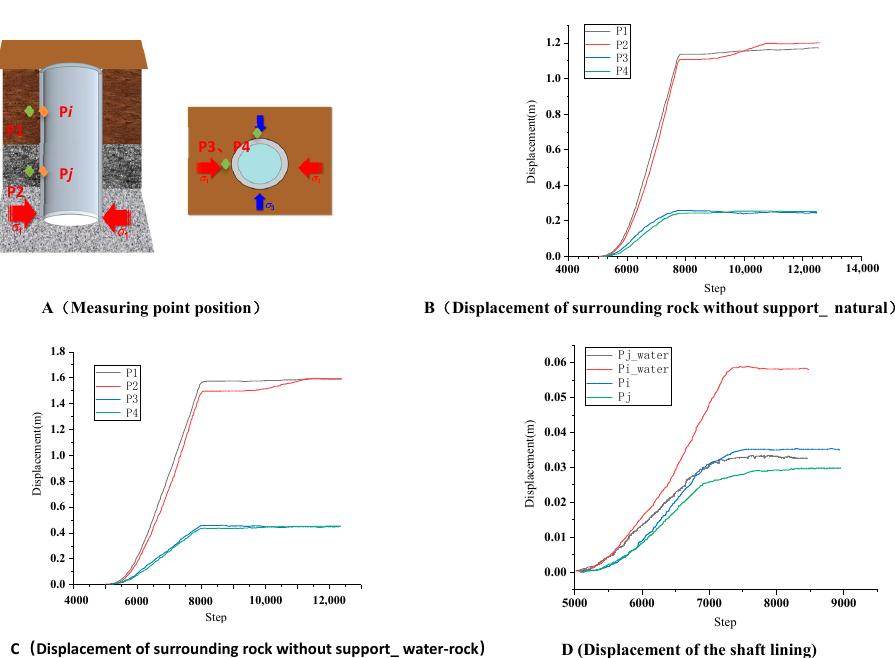
Figure 9. Displacement curves of the monitoring points after shaft excavation.